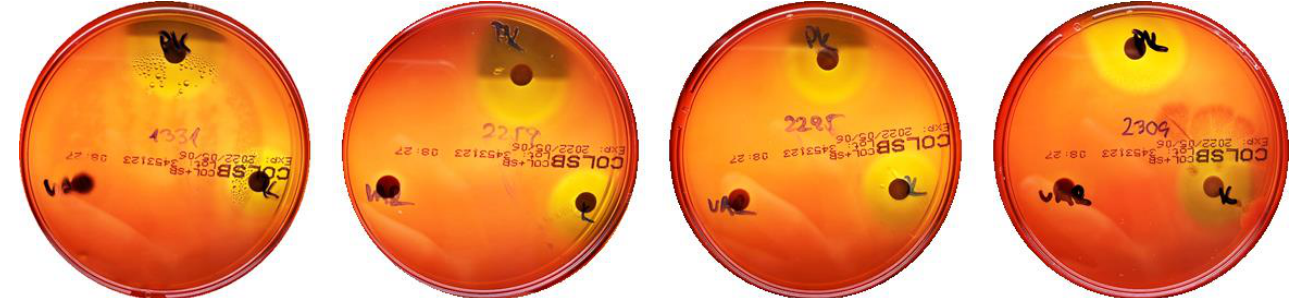
Figure 2. Hemolytic activity of supernatants after proteinase K treatment or boiling. Cell-free supernatants from 72-h-old cultures of strains BCCO 10_1331, BCCO 10_2259, BCCO 10_2295, BCCO 10_2309 (listed from left) were treated by proteinase K (upper discs on each plate) or were boiled (discs on the left of each plate), or no additional treatment have been performed (control discs on the right side of each plate).